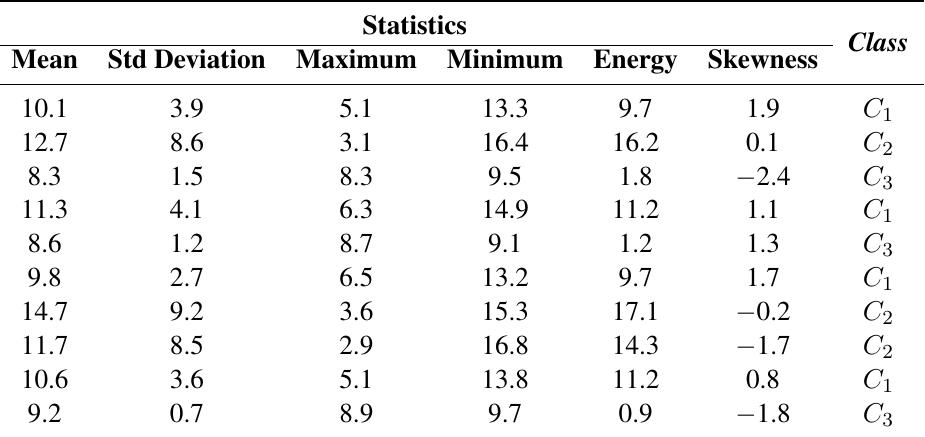
Table 2. Example dataset with 6 statistics, 10 samples and 3 different classes.